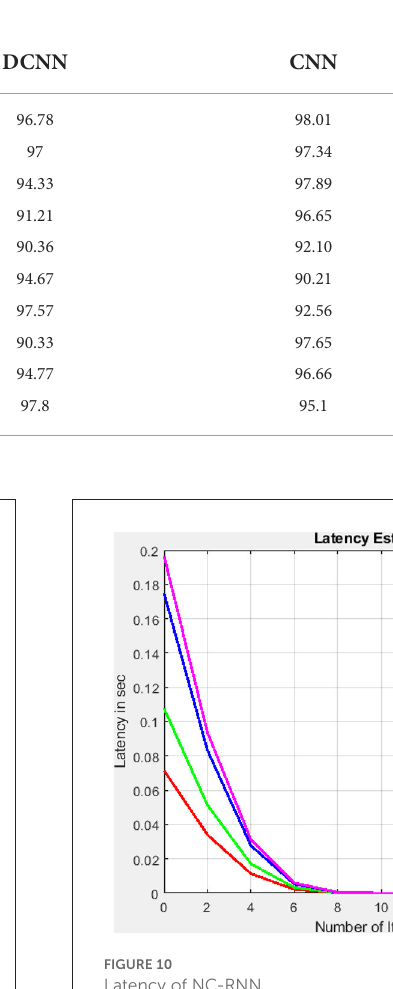
FIGURE9 SNR of NC-RNN.